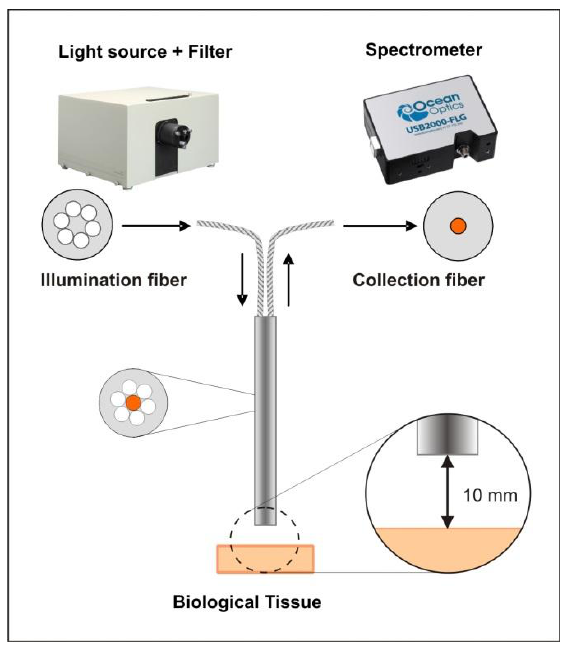
Figure 1. Schematics of the experimental